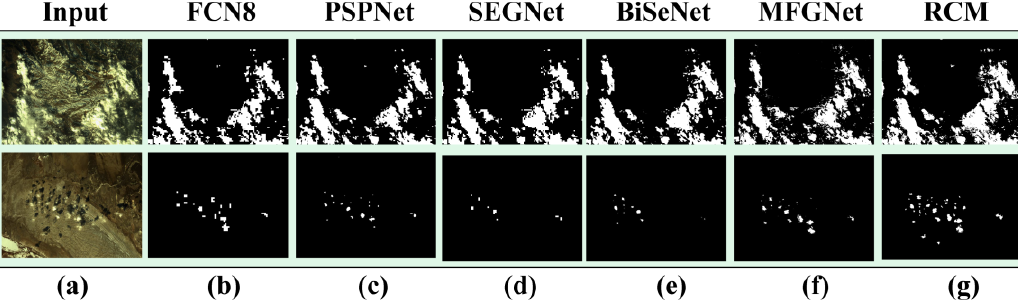
Figure 14. Detailed performance of different algorithms in tough cases. ( a ) the GF-5 preview images. ( b )–( f ) are the prediction result of FCN8, PSPNet, SegNet, BiSeNet, and MFGNet. ( g ) the reference cloud mask.